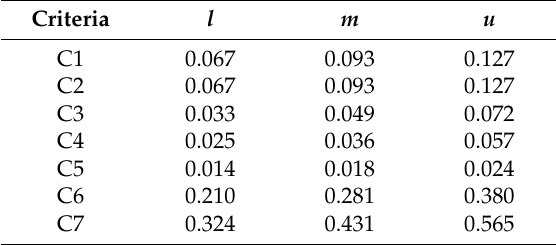
Table 9. Fuzzy weights for all criterion (Expert 1).